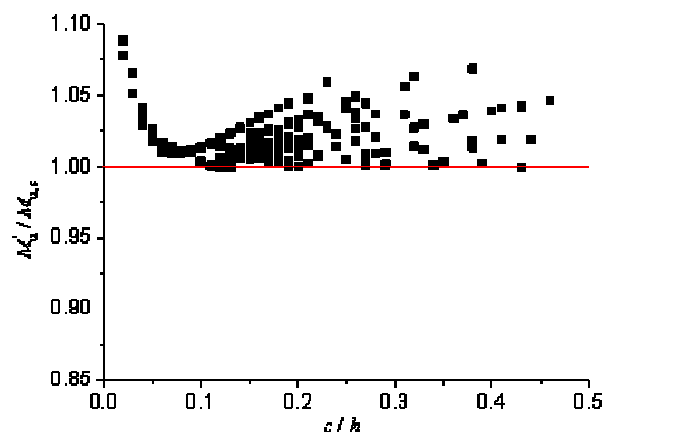
Figure 10. Comparison between the calculated results from modified plastic method and nonlinear